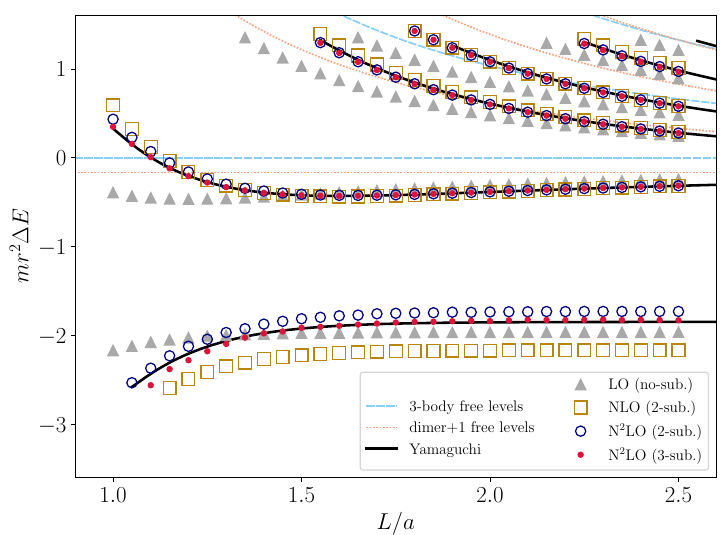
Figure 4 . Comparison of the EFT finite volume energy spectrum in the E -scheme at LO, NLO, and N 2 LO with the Yamaguchi model. For convenience, the free 3-particle and dimer-particle levels are also shown. For explanation of symbols and lines see legend.